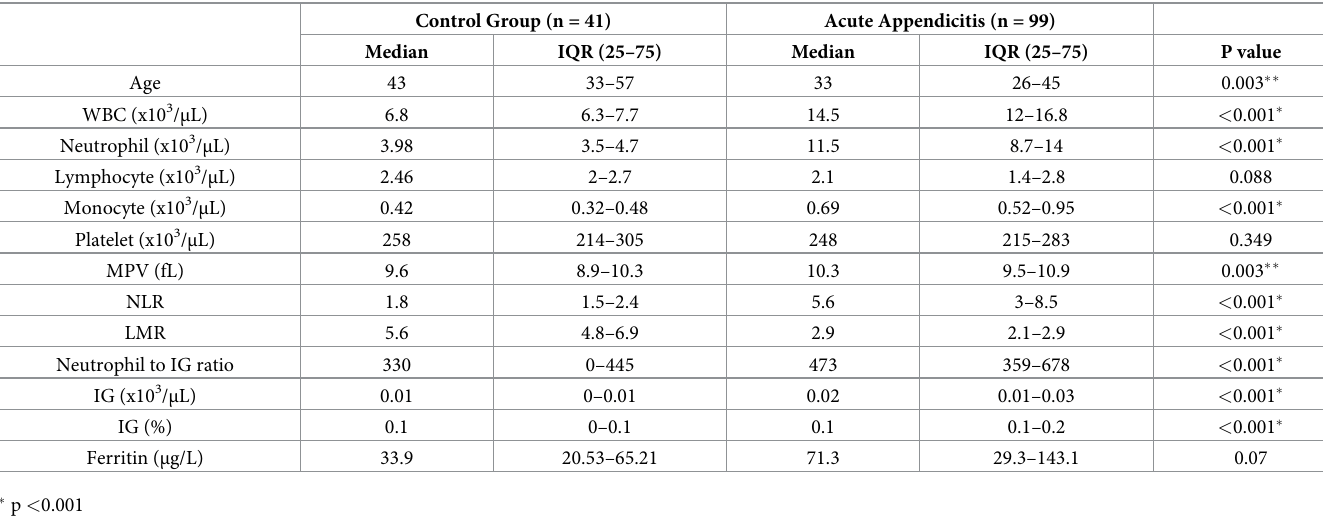
Table 1. Biochemical variables of control and acute appendicitis groups.